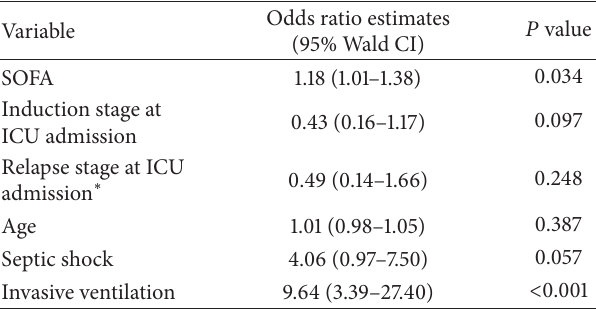
Table 4: Multivariable analysis of independent predictors of ICU